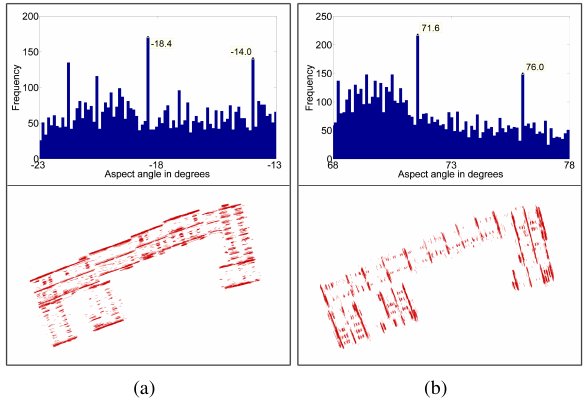
Figure 4. Different aspect angles within complex buildings (a-b) Subset of the aspect angle histogram with side maxima (top) and corresponding 3D line segments